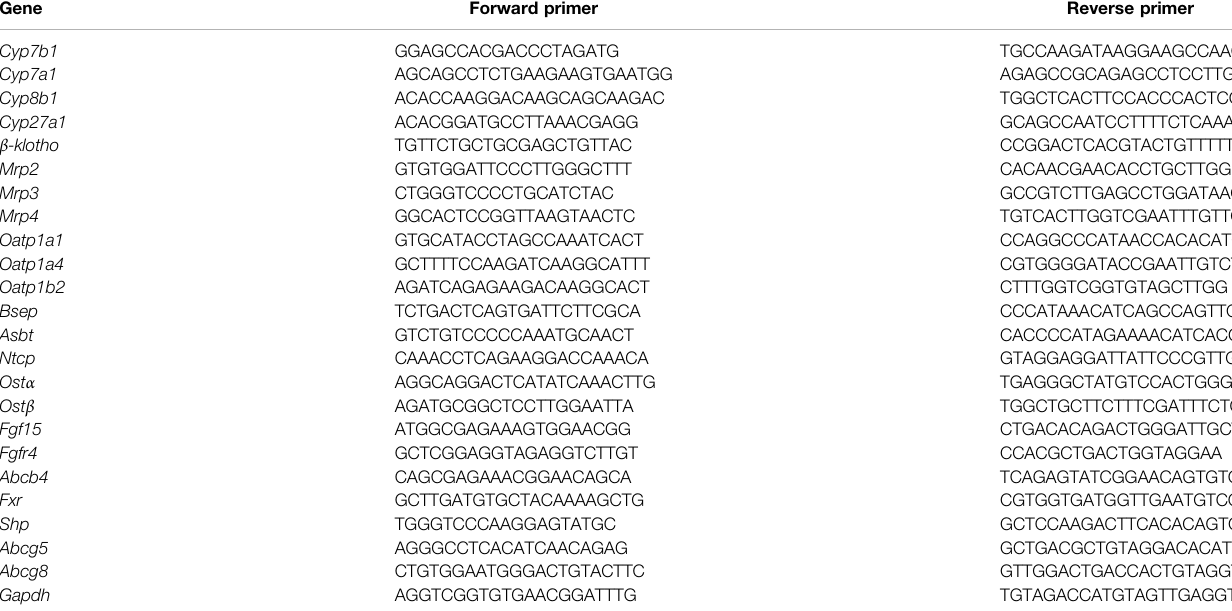
TABLE 1 | Primer sequences for quantitative real-time PCR